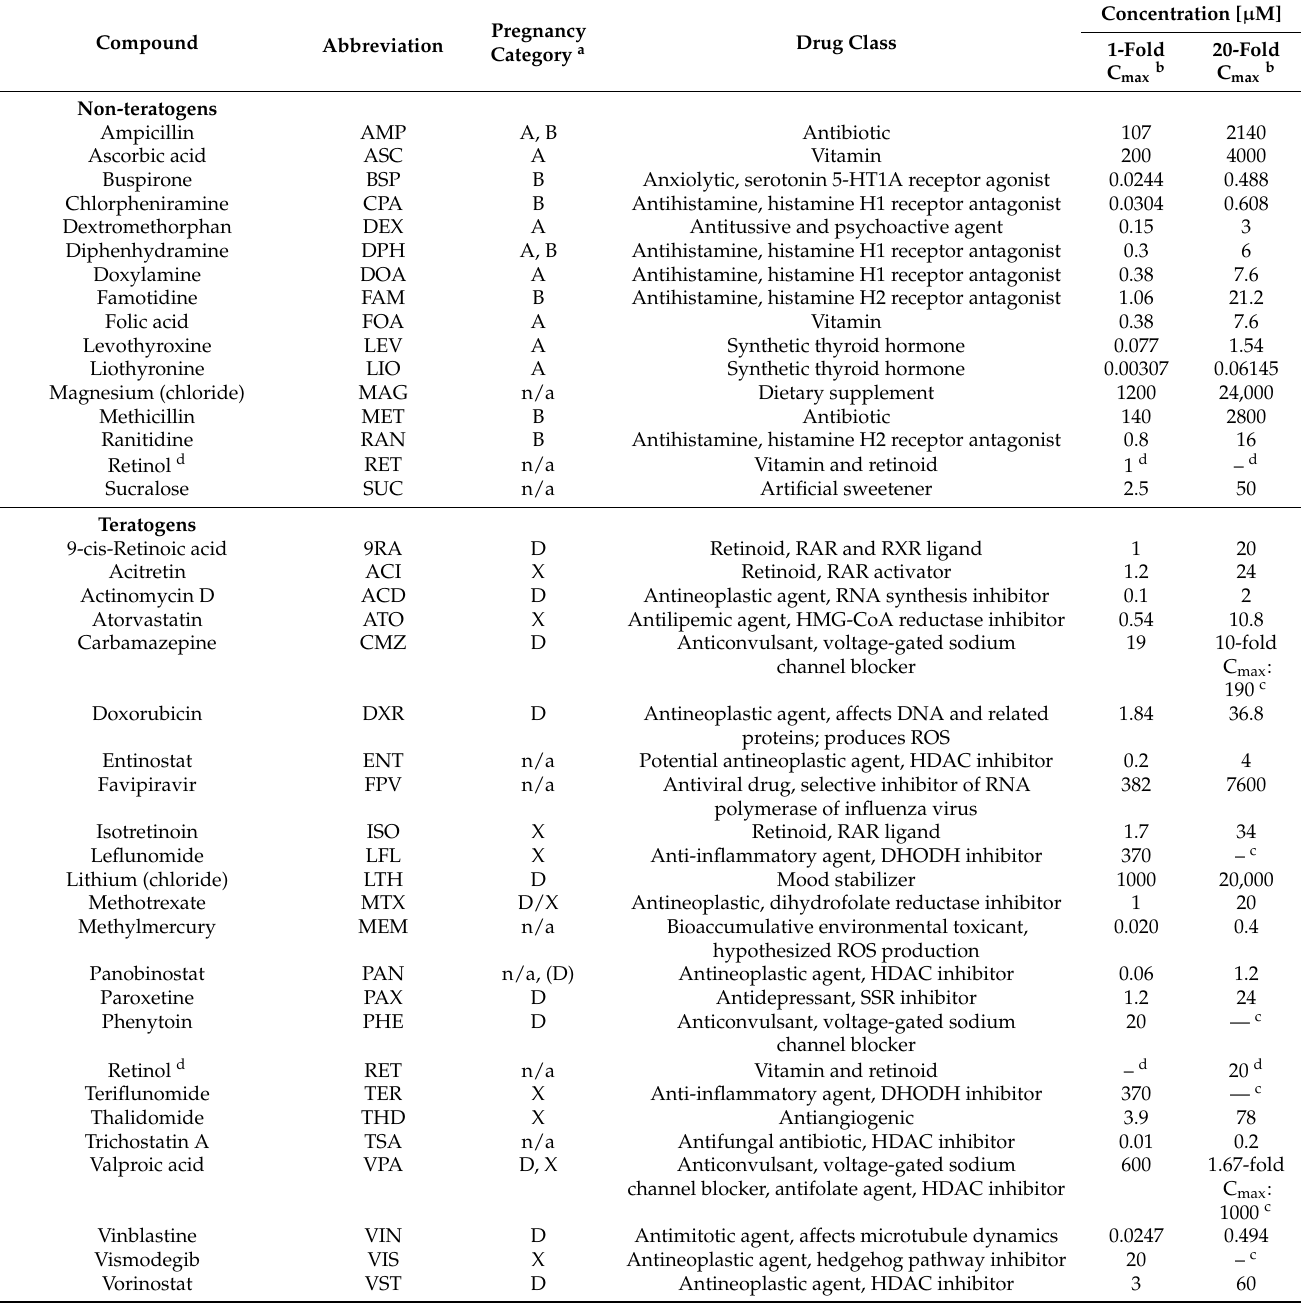
Table 1. Substances and concentrations in the UKN1 test (adapted from Cherianidou et al.,